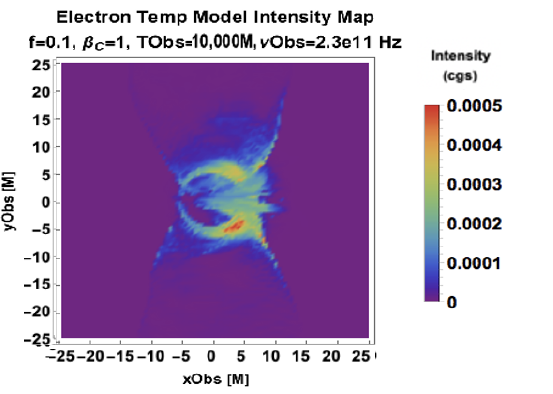
Figure 2. A parameter scan of the Critical Beta Model with ( Left ) f = .1, ( Right ) f = 0.5, β c = 0.01 ( Top ), β c = 0.1 ( Middle ), and β c = 1 ( Bottom ) from an edge-on view. For Sgr A* models, the cgs conversion into Jy is found by multiplying each cgs-intensity-colored pixel value by 57.9 to get its flux density in Jy [9]. The scale is M ≡ GM BH / c 2 when used as a length and ≡ GM BH / c 3 when used as time. The notation 1e2 is a compact form of the scientific notation 1 × 10 2 .